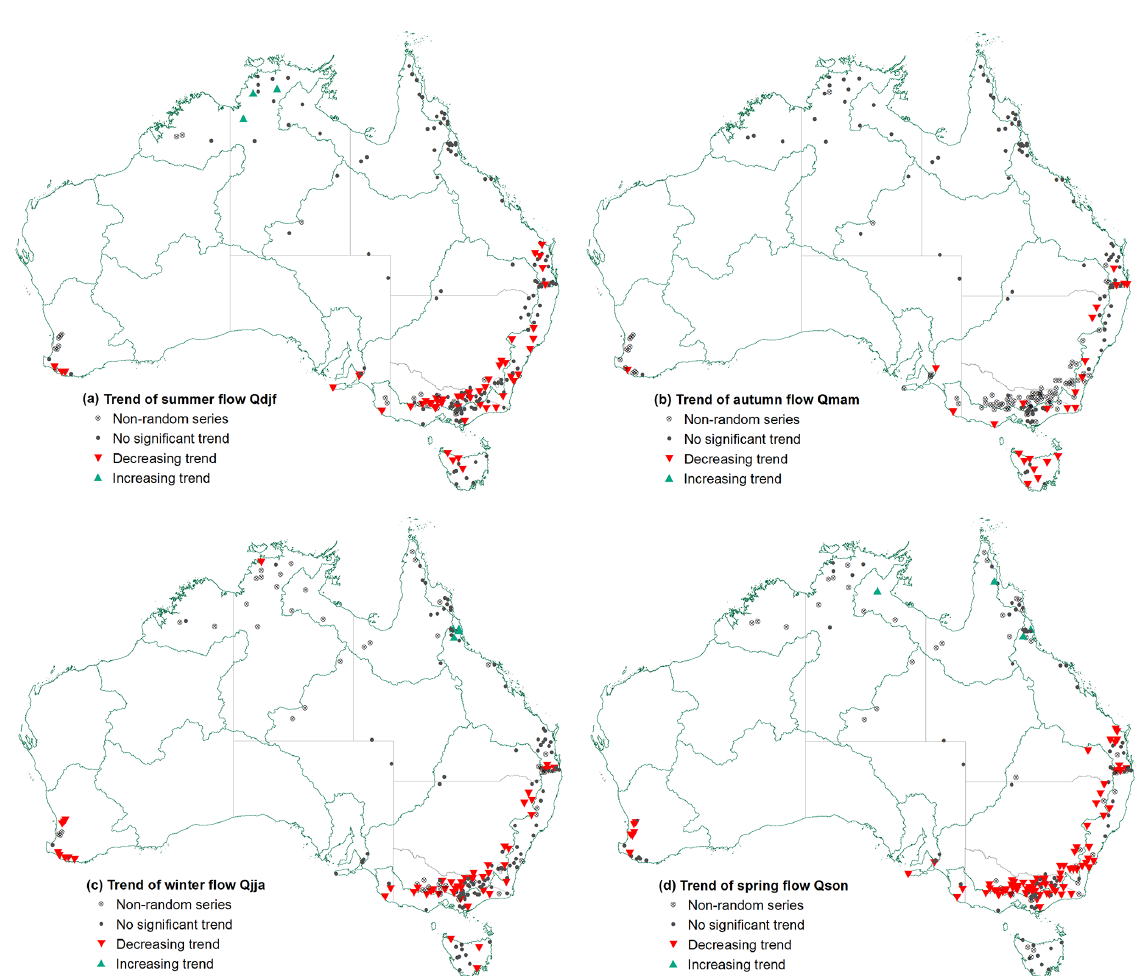
Figure 9. Maps showing trends of seasonal flow in (a) Q DJF summer flow; (b) Q MAM autumn flow; (c) Q JJA winter flow; (d) Q SON spring